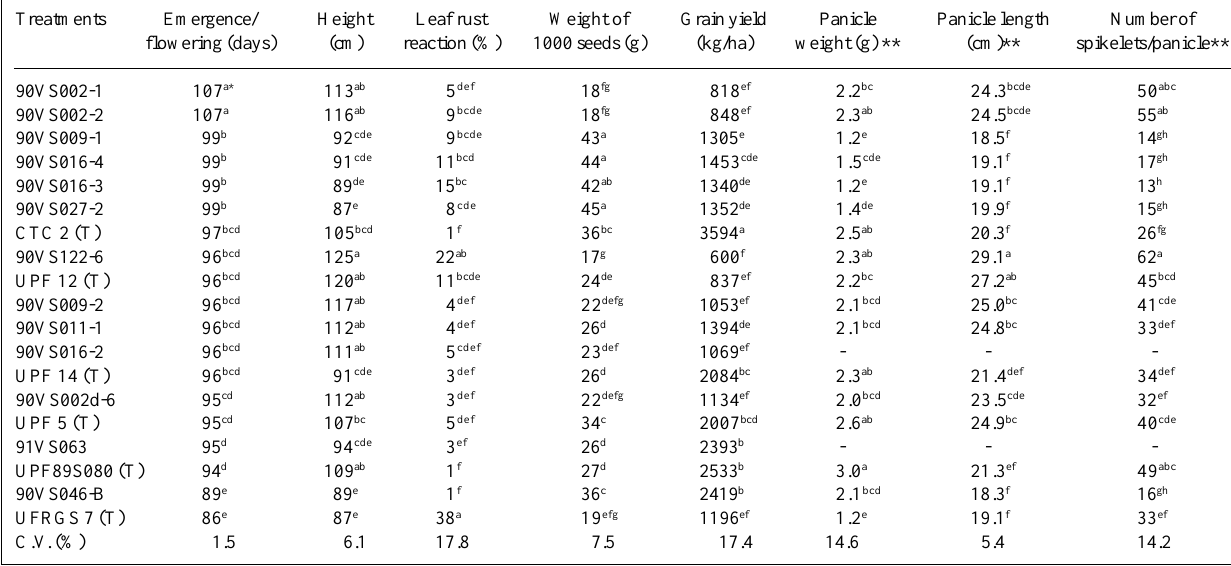
Table I - Comparison of means from oat somaclones derived from cultivar UPF 12 and controls for the following characteristics: days between emergence and flowering, plant height, leaf rust reaction, weight of a thousand seeds, grain yield, panicle weight and length and number of spikelets/panicle. Experiment 1. Eldorado do Sul, RS, 1993.